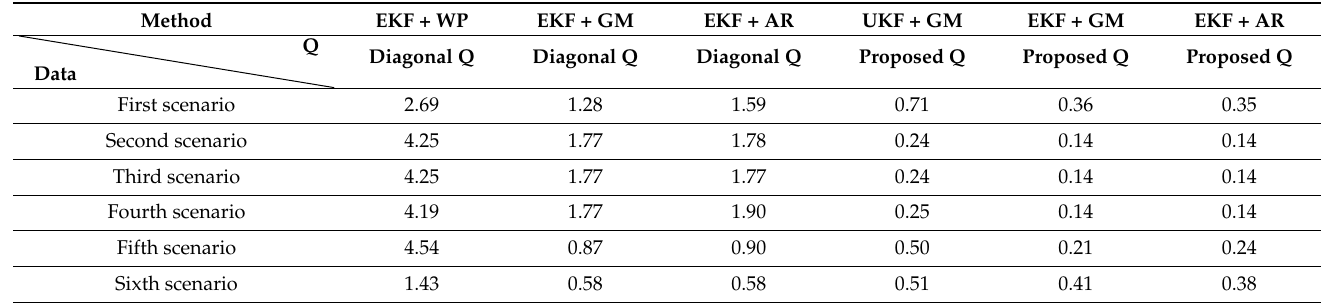
Figure 19. The positioning error of different methods in the fourth scenario. Table 1. The positioning error (RMSE) caused by different methods in